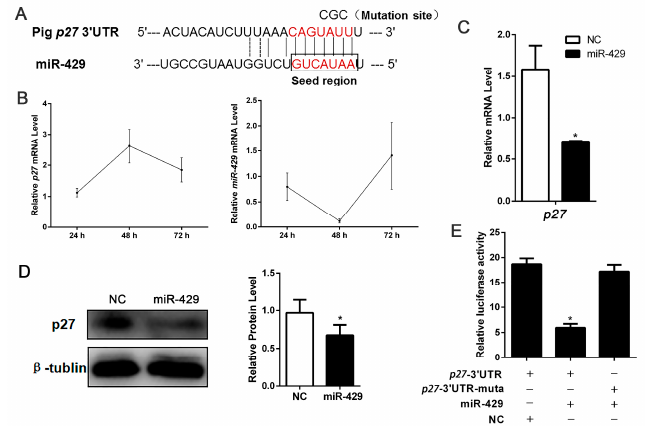
Figure 7. miR-429 can target p27 and downregulate the expression of p27 in PSPAs. ( A ) Target site of miR-429 within porcine p27 mRNA 3 ′ -UTR and mutational site of p27 3 ′ -UTR (CGC replace UAU); ( B ) miR-429 and p27 temporal expression at 24, 48 and 72 h; The mRNA ( C ) and relative protein ( D ) level of p27 in PSPAs were detected after 48 h of transfection; ( E ) p27 mRNA 3 ′ -UTR or its mutation dual-luciferase vector was co-transfected with miR-429 agomir/NC into PSPAs. Dual-luciferase assay was performed at 48 h after transfection. Results are indicated as means ± SEM; n = 3; * p < 0.05.